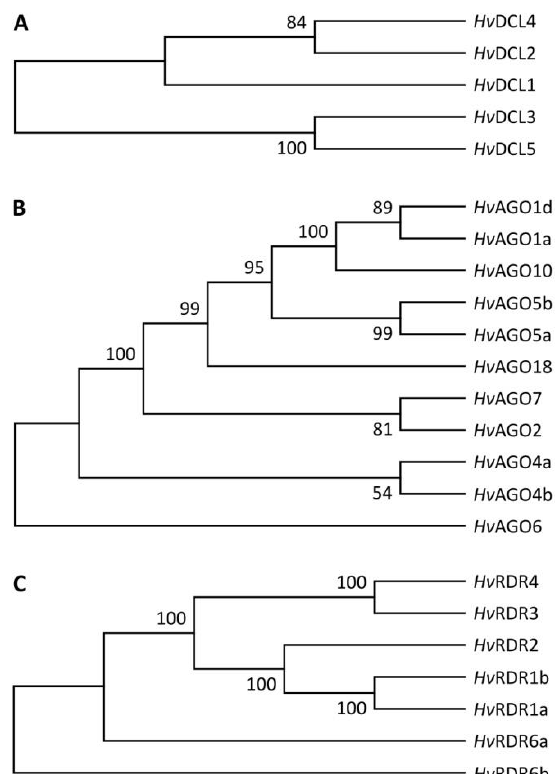
Figure 1. Phylogenetic relationship of the predicted barley DCL ( A ), AGO ( B ), and RDR ( C ) proteins. The evolutionary history was inferred using the Neighbor-Joining method [75]. The bootstrap consensus tree inferred from 1000 replicates [76] is taken to represent the evolutionary history of the taxa analysed. Branches corresponding to partitions reproduced in less than 50% bootstrap replicates are collapsed. The percentage of replicate trees in which the associated taxa clustered together in the bootstrap test (1000 replicates) are shown next to the branches. The evolutionary distances were computed using the Poisson correction method and are in the units of the number of amino acid substitutions per site. All ambiguous positions were removed for each sequence pair (pairwise deletion option). There were a total of 2145 ( A ), 1302 ( B ), and 1393 ( C ) positions in the final dataset. Evolutionary analyses were conducted in MEGA X [73].